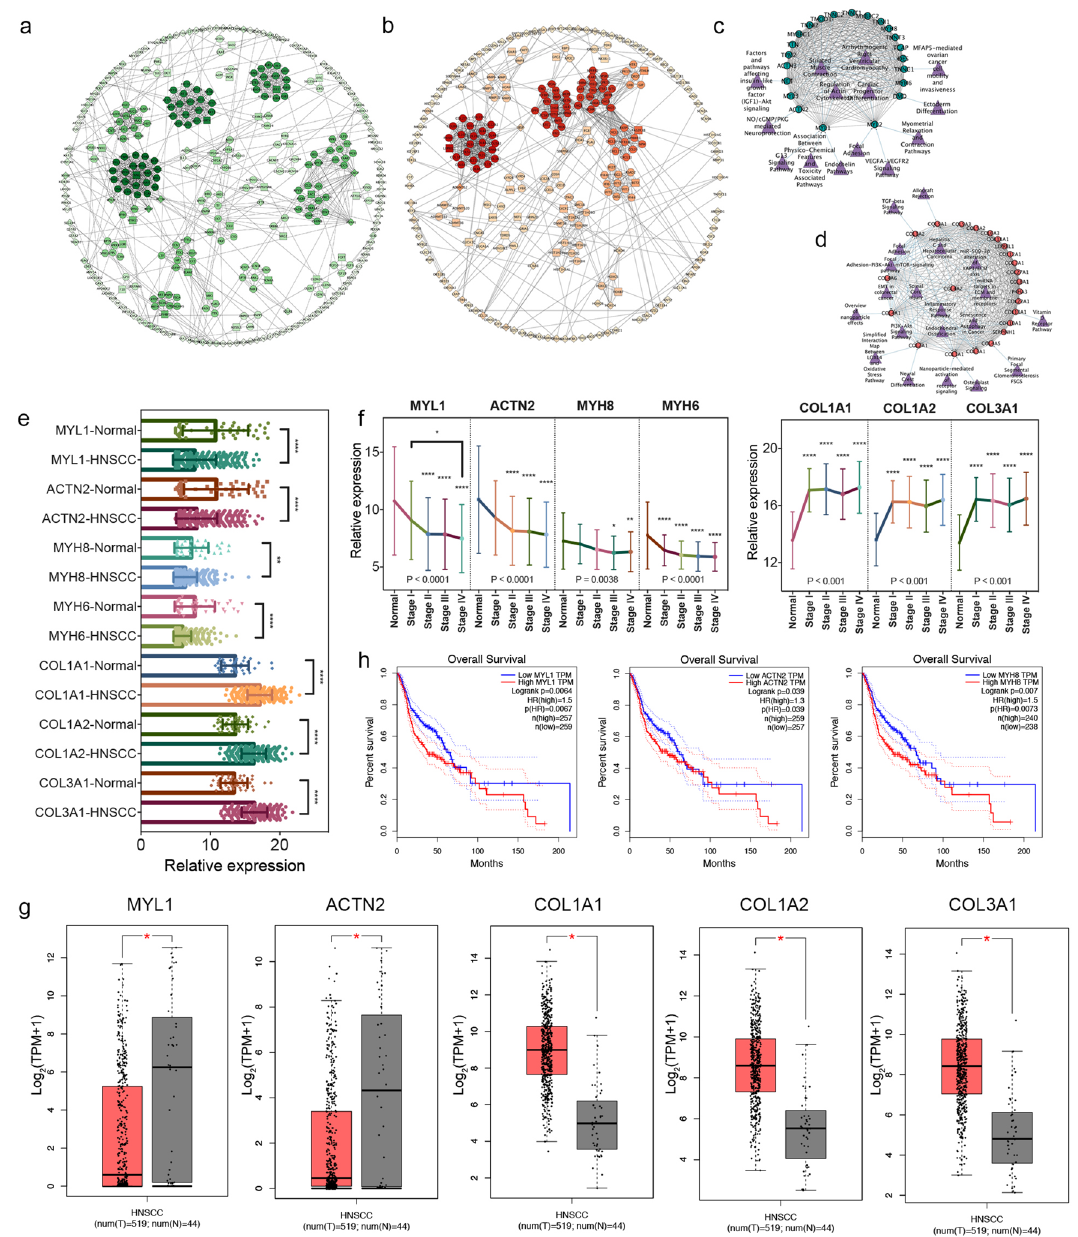
Figure 4. PPI networks and key mRNAs analysis in HNSCC. ( a ) Downregulated PPI network with 343 nodes and 1188 edges. The green color intensity was proportional to cluster scores. ( b ) Upregulated PPI network with 256 nodes and 1032 edges. The red color intensity was proportional to cluster scores. ( c , d ) Pathway-gene networks. Green circles represented downregulated DEmRNAs, and red circles represented upregulated DEmRANs. Purple triangles represented pathways. ( e ) Bar plots of expression levels of seven key mRNAs between HNSCC samples and normal samples. MYL1, ACTN2, MYH8 and MYH6 were significantly downregulated in HNSCC samples, and COL1A1, COL1A2 and COL3A1 were over-expressed. ( f ) The expressions of seven key mRNAs had significant difference between clinical stages. ( g ) Validation of gene expressions from GEPIA database. ( h ) Survival analysis. Higher expression of MYL1, ACTN2 and MYH8 resulted in worse overall survival of HNSCC patients. *: P < 0.05; **: P < 0.01; ***: P < 0.001; ****: P < were lower than that in the low-risk group at different clinical stages, which suggested some of the patients with clinical early-stage (stage I or II) were supposed to belong to the high-risk group and were likely to have a poor prognosis (Fig. 7i). Moreover, the expressions of the RNAs (expect RYR3) between alive- and dead-group were also observed, which were consistent with the above expression patterns (Fig. 7j).